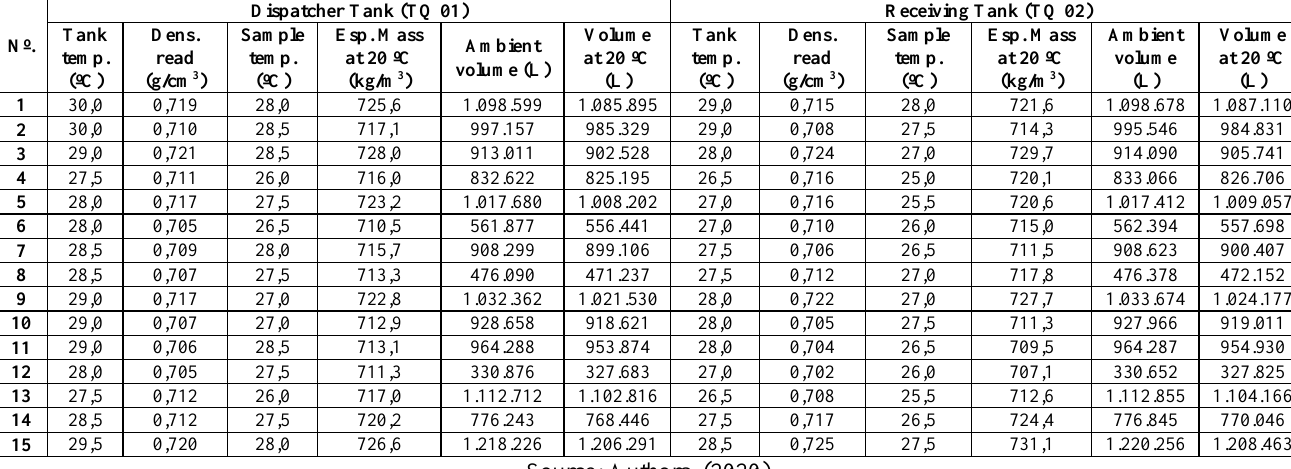
Table 4: Data collected from CACL and QC for transfers of Gasoline A (15 samples - October 2020 - process review). Nº.